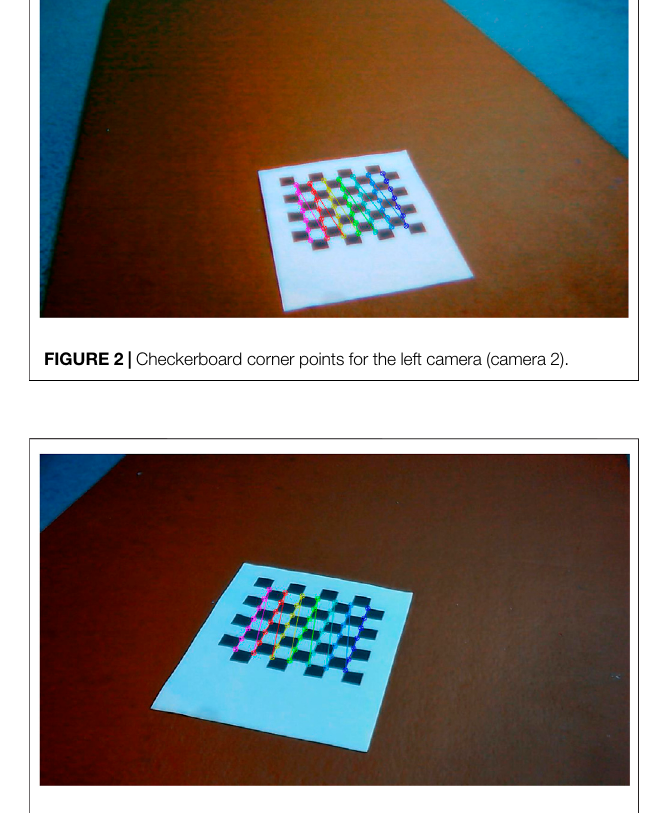
FIGURE3| Checkerboardcornerpointsfortherightcamera(camera1).